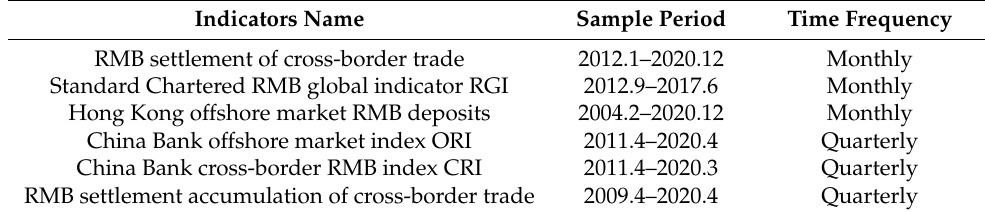
Table 1. RMB internationalization indicators.